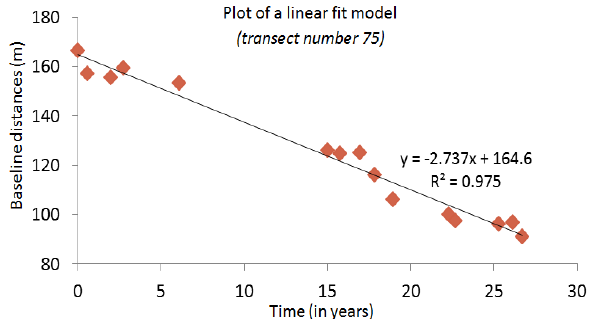
Figure 9. Linear regression fit between baseline distances and time for transect number 75 (numbering concerning the sector B), with Landsat midlines for 1984-2011. Time variable indicates the difference in years from the first value of the time